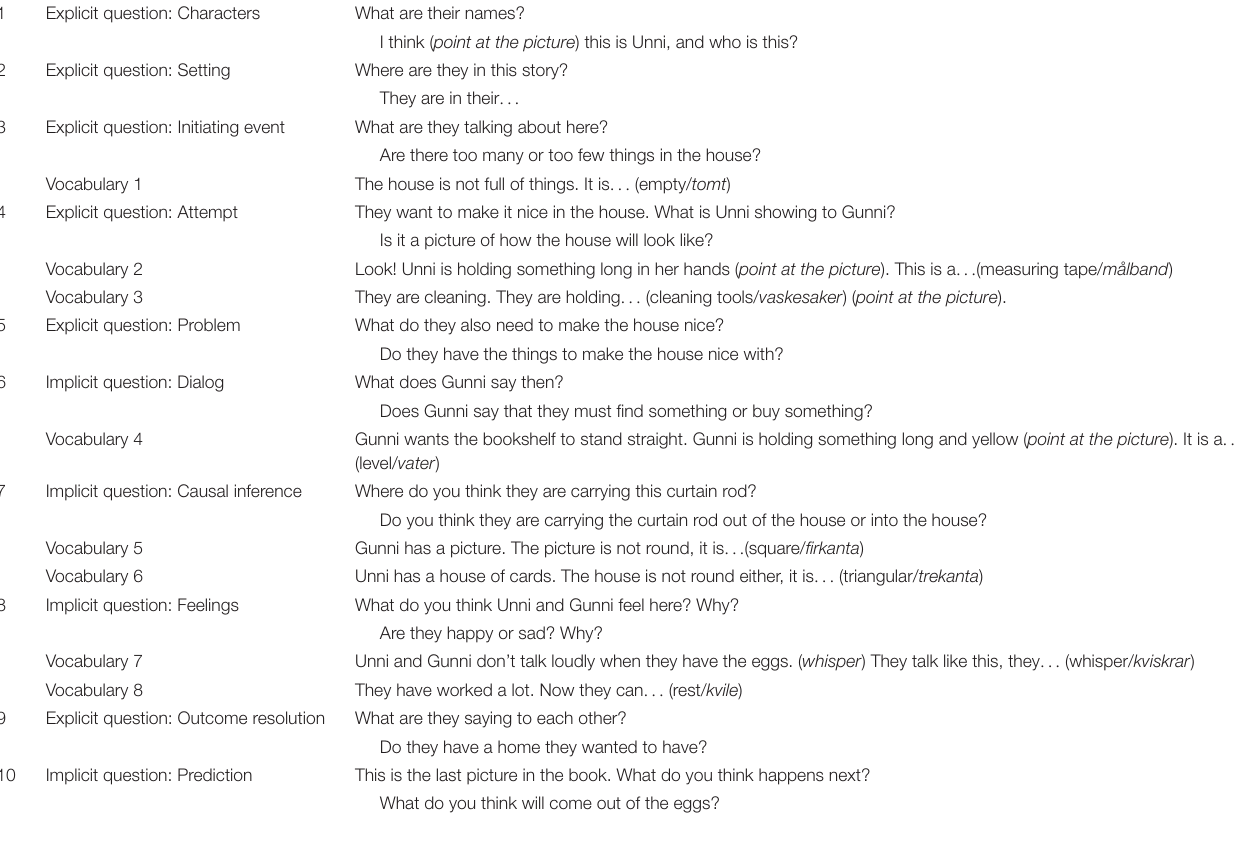
TABLE A1 | Book: Unni og Gunni gjer det fint [Unni and Gunni make it